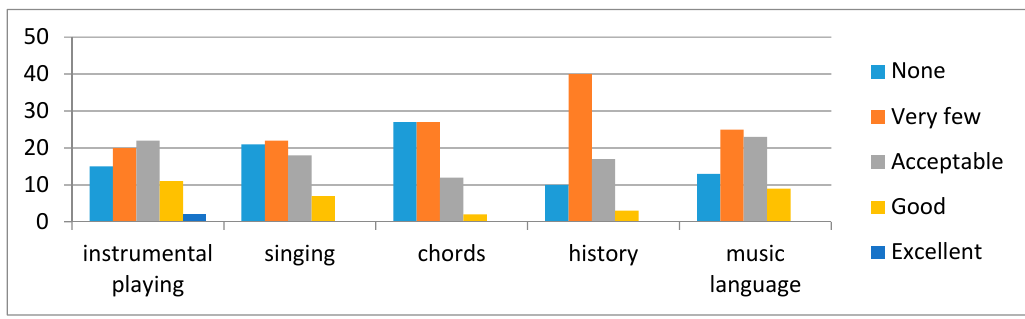
Figure 4. Perception of musical performance.